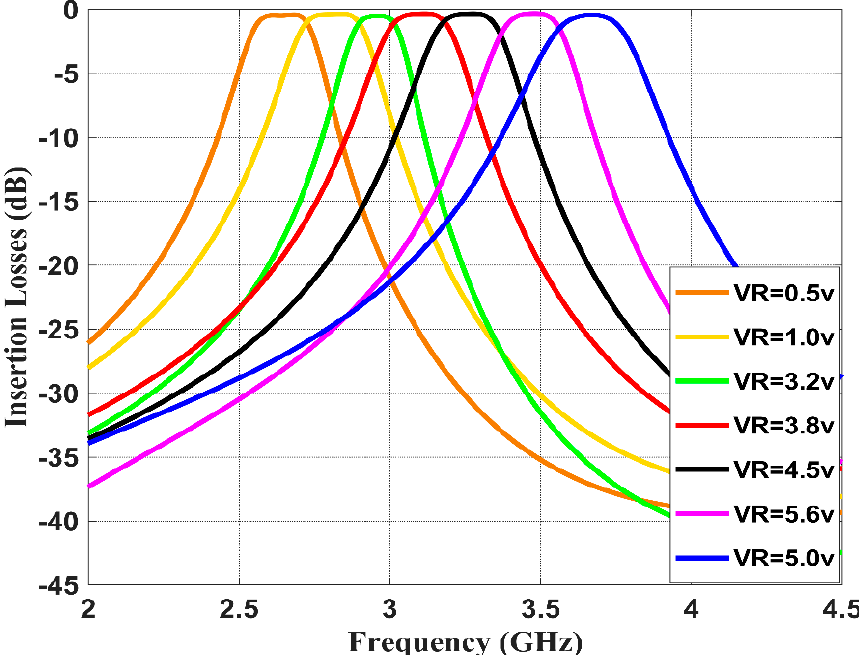
Figure 12. Simulated insertion losses with different DC reverse bias voltages for the presented reconfigurable filter.